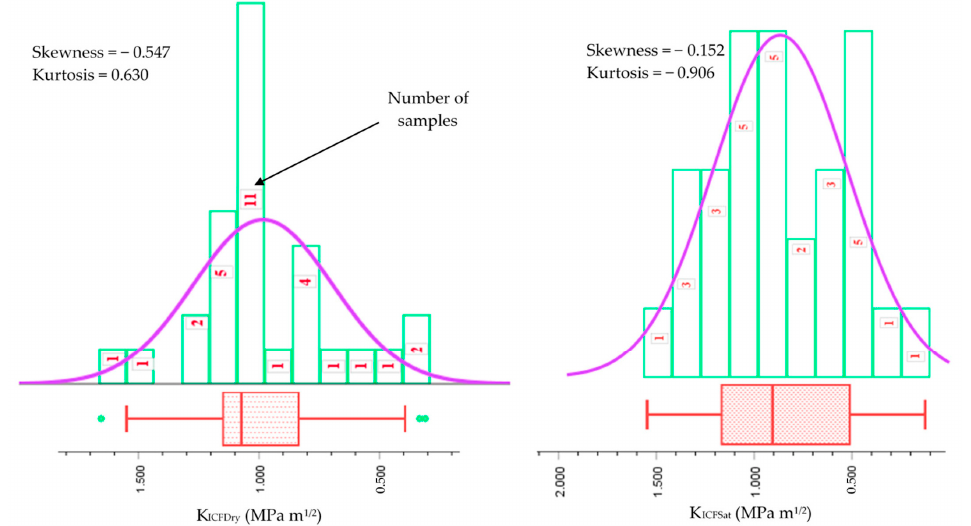
Figure 9. Histograms and boxplots of the dependent